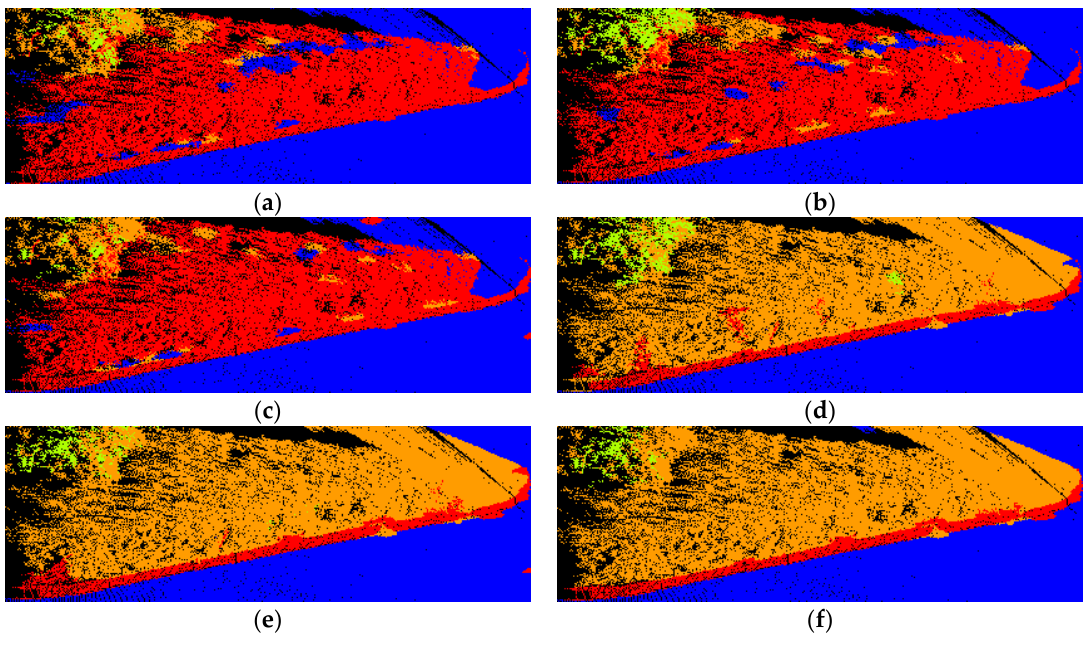
Figure 9. Examples of the misclassification of vegetation with different feature sets: ( a ) Geo, ( b ) Geo & I, ( c ) Geo & CI, ( d ) Geo & C, ( e ) Geo & C & OI, ( f ) Geo & C & CI.